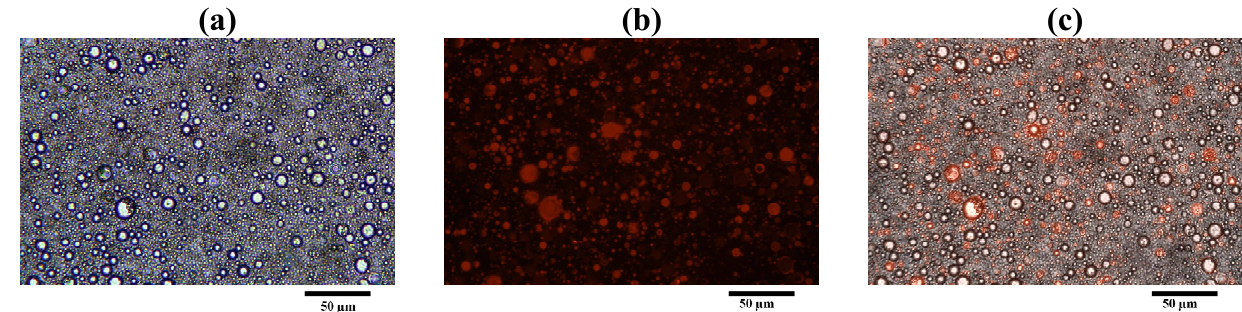
Figure 11. Morphology of LEV-proliposome formulation No.1 reconstituted in distilled water and stained with Lumidot ® 640 in different mode; ( a ) bright field; ( b ) fluorescence; ( c ) overlay (bar = 50 µm).